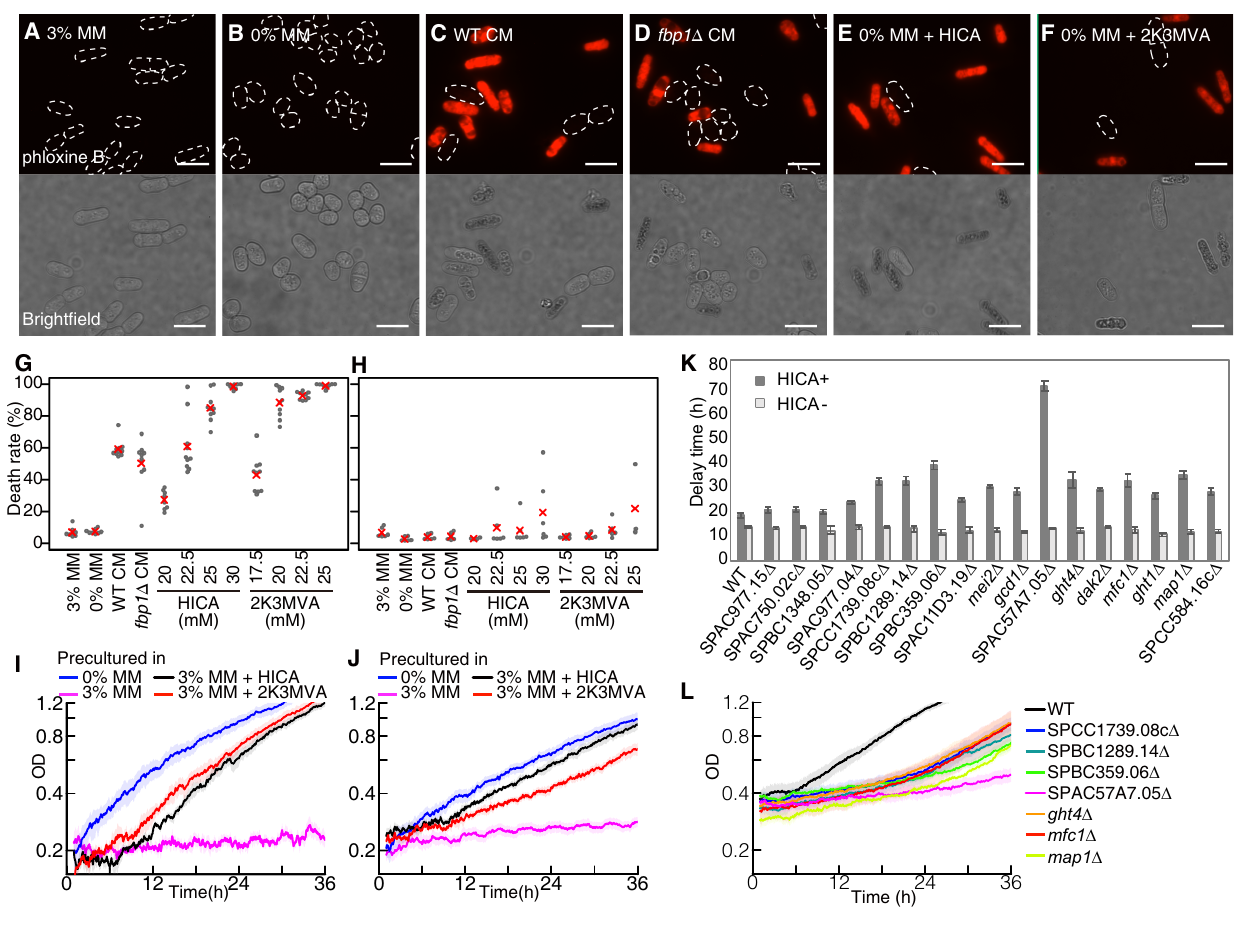
Fig 3. Identified molecules kill cells and also facilitate cell adaptation to the molecule and deletion of some genes up-regulated in adapted cells prolonged the delay phase. ( A – F ) Fluorescent (upper) and brightfield (bottom) microscopic images of WT cells in various media after 24 h of incubation. Cells precultured in 3% MM were transferred to ( A ) 3% MM, ( B ) 0% MM, ( C ) WT CM, ( D ) fbp1 Δ CM, ( E ) 0% MM with 25 mM HICA, and ( F ) 22.5 mM 2K3MVA. In fluorescent microscopic images, dead cells were stained with phloxine B. Scale bar indicates 10 μ m. ( G and H ) The dyed cell ratio after 8 h of incubation. Cells were precultured in ( G ) 3% MM ( n = 8–10) or ( H ) 0% MM ( n = 3–6). Grey dots represent the dyed cell ratio in each sample, and red crosses represent the mean value. ( I and J ) Growth curves of cells precultured in the presence of one of the inhibitory molecules along with 3% glucose, in 0% MM with ( I ) 30 mM